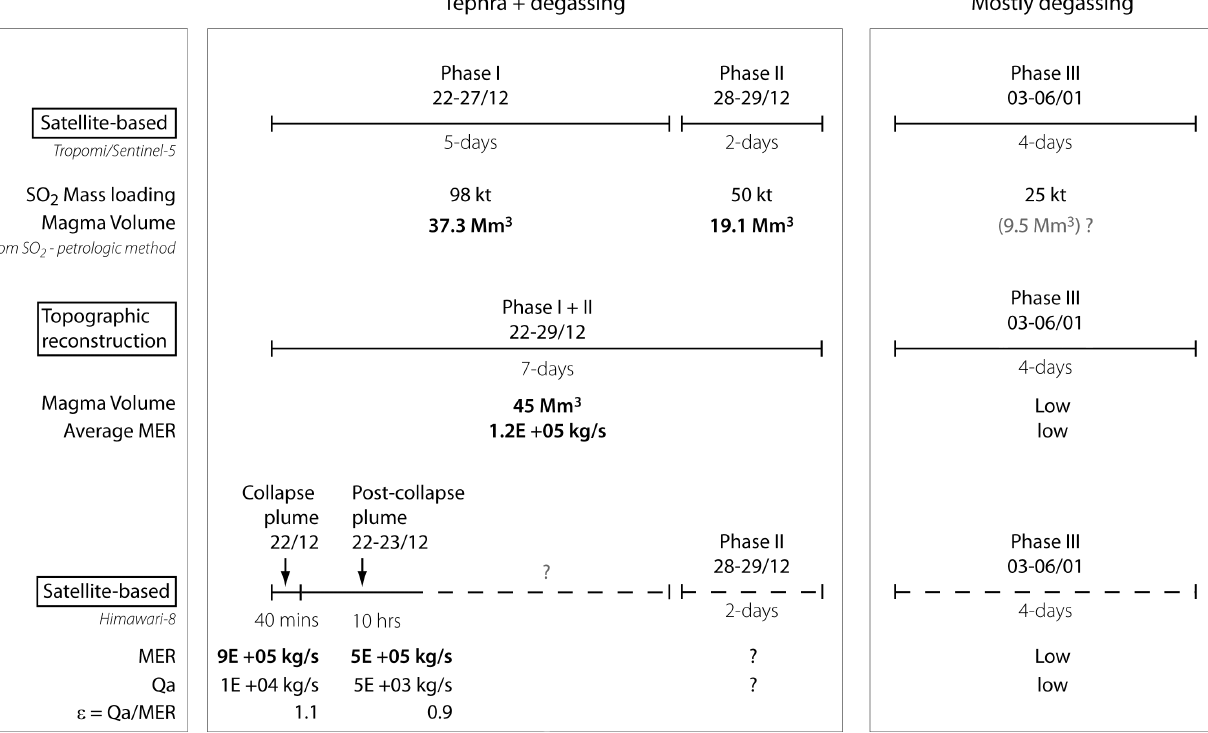
Figure 7: Main parameters for the December 2018–January 2019 eruption of Anak Krakatau summarizing the budget of material emplaced after the collapse from di ff erent techniques and spanning di ff erent time scales. “ kt ” stands for kilotons, “Mm 3 ” for millions of cubic meters, “MER” is Mass Eruption Rate, “ Q a ” is the airborne fine ash flux, “ (cid:15) ” is the ratio between the airborne fine ash flux and the Mass Eruption